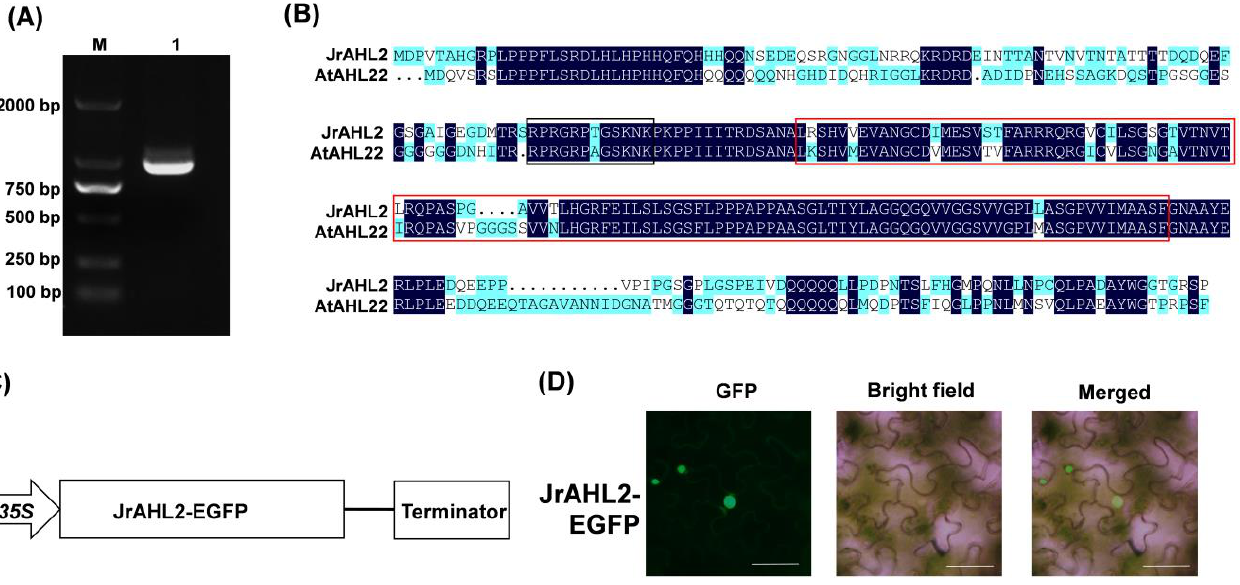
Figure 10. JrAHL2 gene cloning and subcellular localization. ( A ) Gene cloning of JrAHL2 coding region. ( B ) Putative protein sequence analysis of the cloned JrAHL2 gene. ( C ) Schematic diagram of the JrAHL2 overexpression vector for subcellular localization. ( D ) Subcellular localization of JrAHL2 in tobacco leaves.